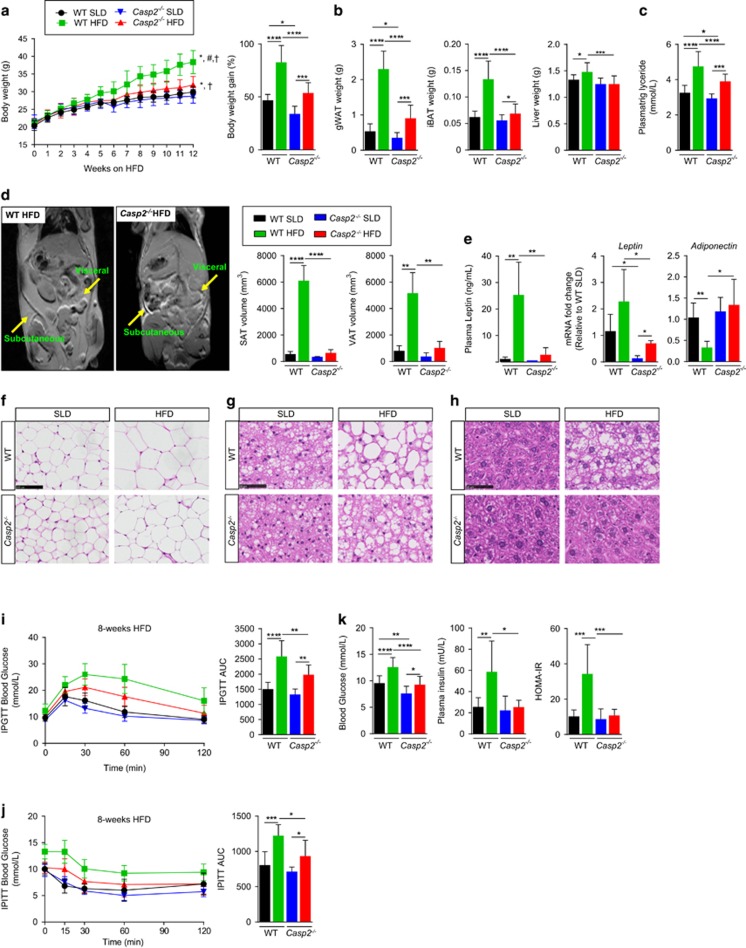
Caspase-2 deficiency protects from HFD-induced obesity and results in metabolic improvements. WT and Casp2−/− mice were fed HFD for 12 weeks and blood and tissue collected following a 6-h fast. (a) Body weight and weight gain over 12-week period (n=11–15 per group). (b) Weight of gWAT, iBAT and liver (n=14–16). (c) Fasting plasma triglycerides (n=11–14 per group). (d) MRI of HFD-fed mice after 12 weeks and calculated volumes of SAT and VAT (n=3 per group). (e and f) Adipokines assessed by measurement of (e) plasma leptin (n=8–10), and mRNA expression in gWAT (n=5–6). (f–h) representative images of H&E staining of (f) gWAT, (g) iBAT and (h) liver, scale bar=50 μm. (i) IPGTT and (j) IPTT was performed on WT and Casp2−/− mice (n=7–8 per group) at 13 weeks of age after 8 weeks on HFD. (k) Fasting blood glucose (n=14–16 per group), plasma insulin (n=8–10 per group) and calculated homeostatic model assessment of insulin resistance (HOMA-IR) (n=8–10 per group) measured after 12 weeks on HFD. Mice were used at 16–17 weeks (including 12 weeks HFD feeding) unless otherwise stated. Values are means±S.D. (bar graphs) or means±S.E.M (scatter plots). Statistical significance indicated as *P<0.05, **P<0.01, ***P<0.001, ****P<0.0001